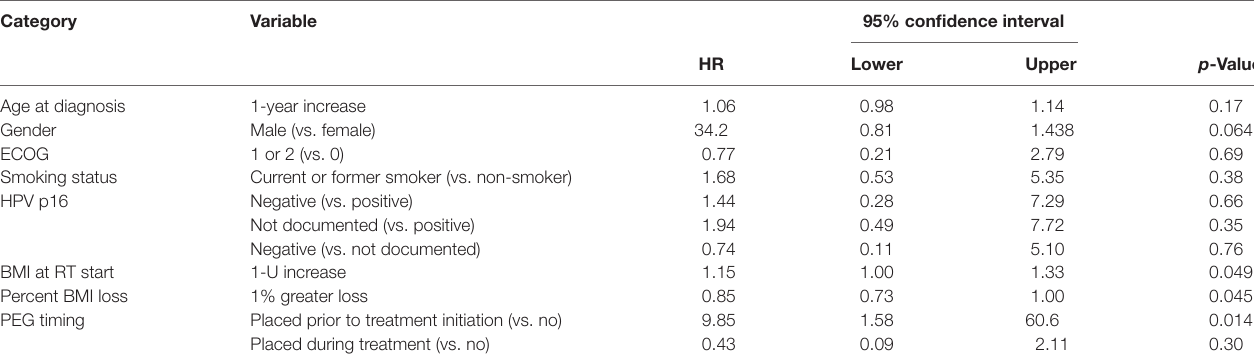
Table 2 | Multivariate analysis of association with time to disease